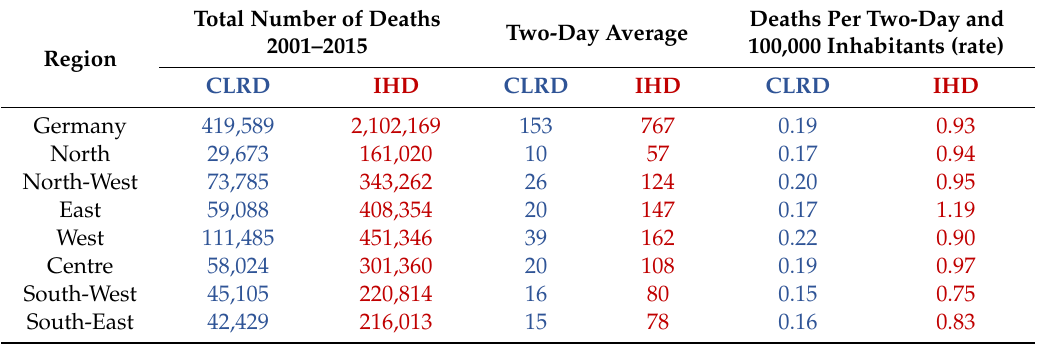
Table 1. Total number and two-daily averages of deaths due to chronic lower respiratory diseases (CLRD, blue) and ischemic heart diseases (IHD, red), as well as two-daily rate (deaths per two days and 100,000 inhabitants), in seven regions of Germany, in the period 2001–2015.